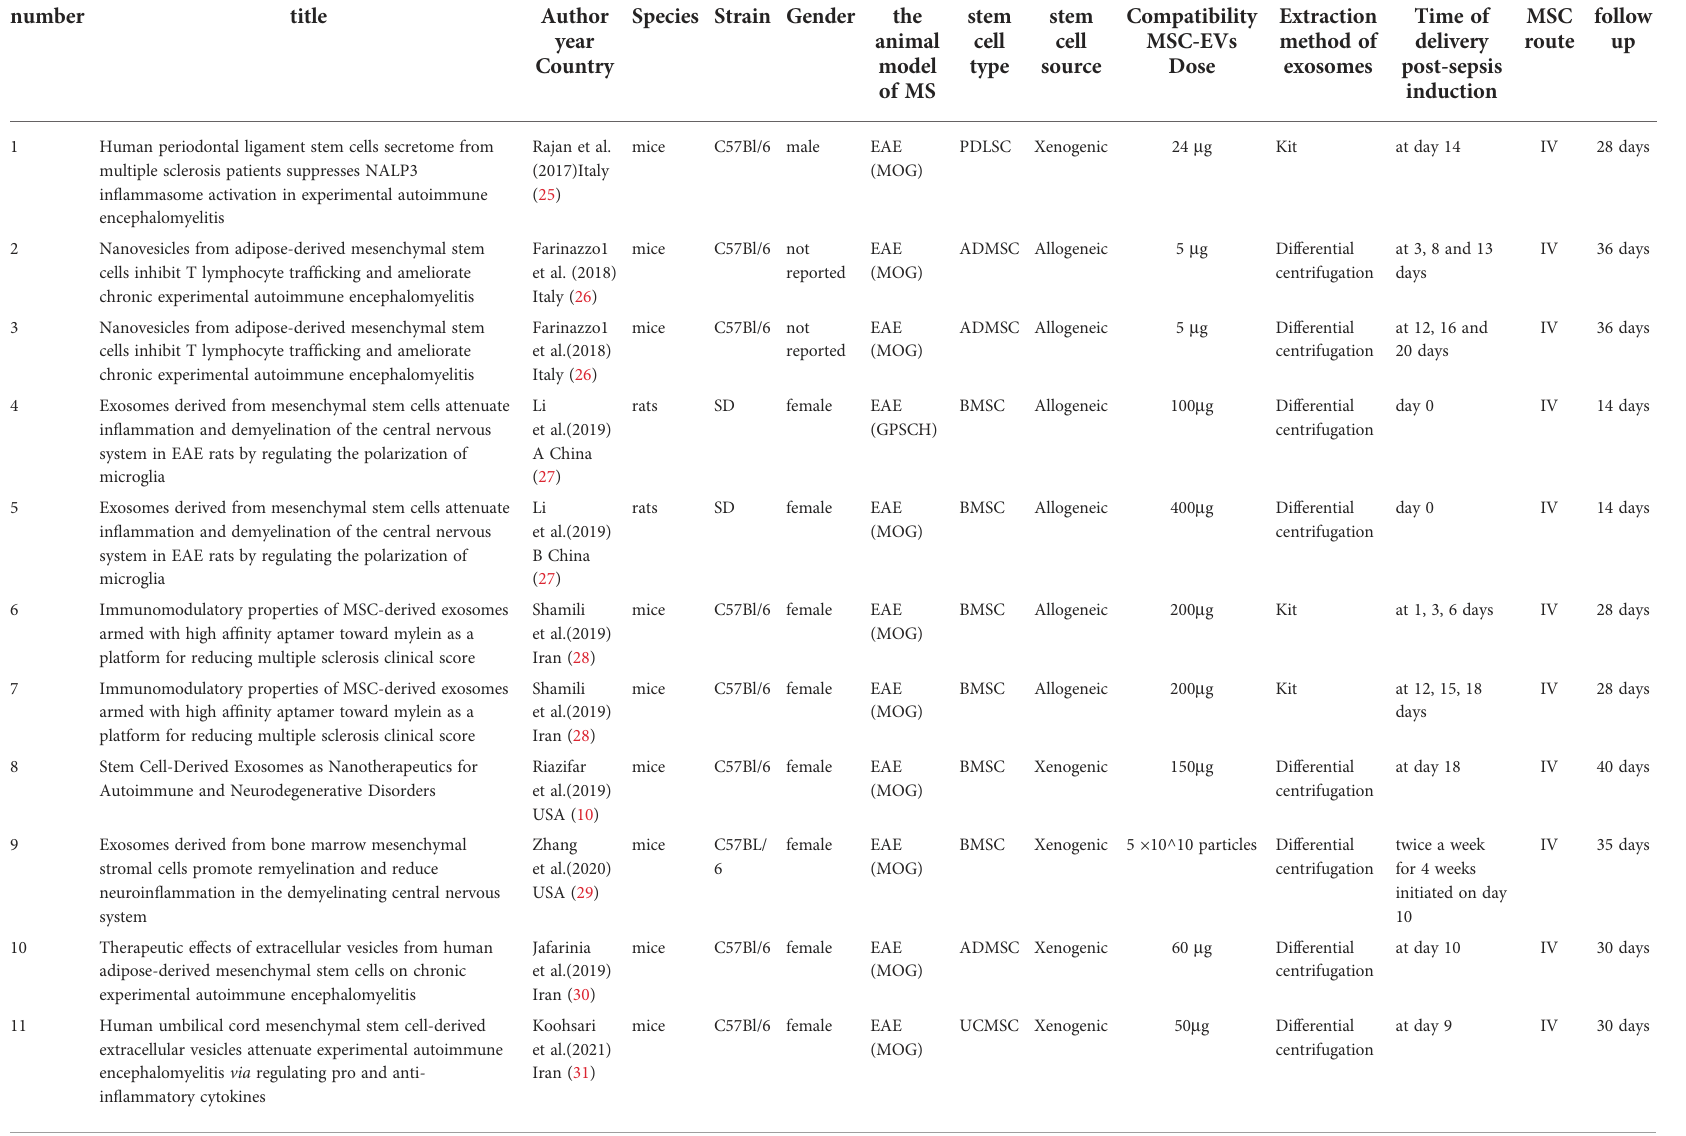
TABLE 1 Summary of study characteristics of all included